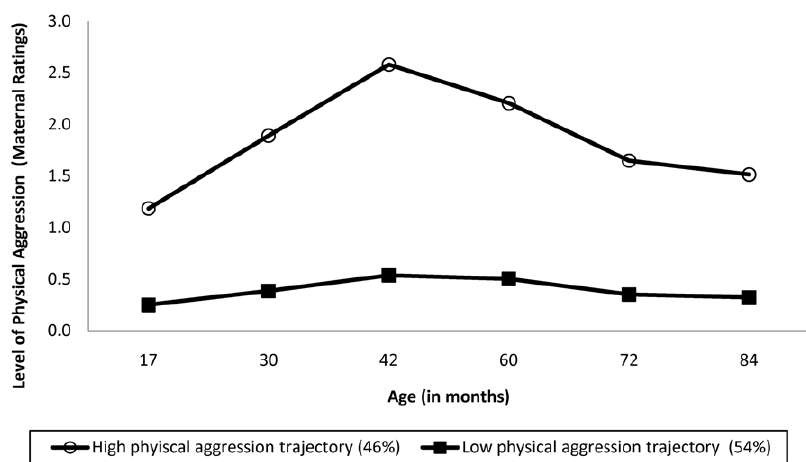
Figure 1. Physical aggression trajectories from 17 to 84 months.